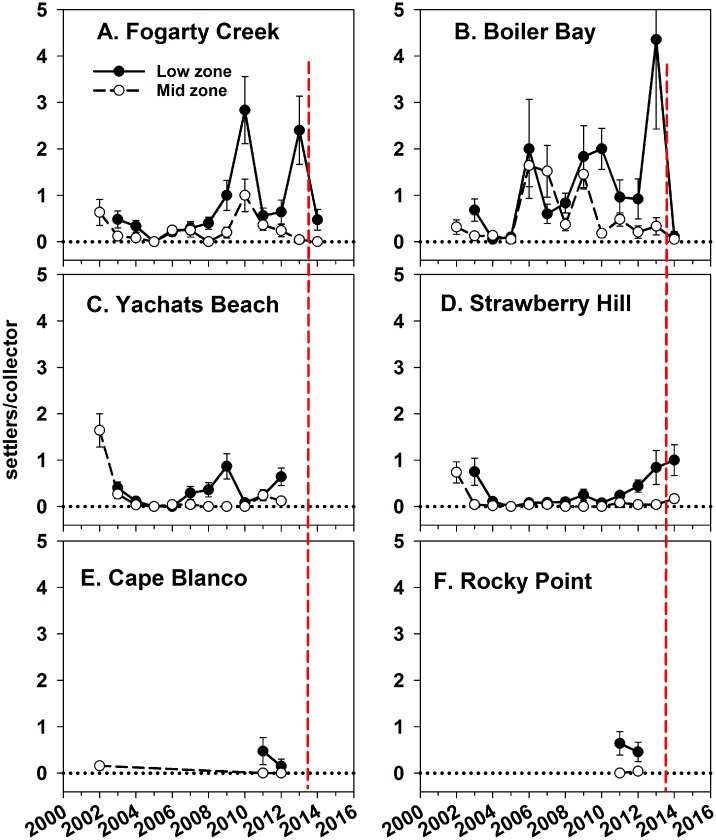
Annual average (± 1SE) number of P. ochraceus settlers at four sites.Vertical dashed line indicates the onset of SSWD.